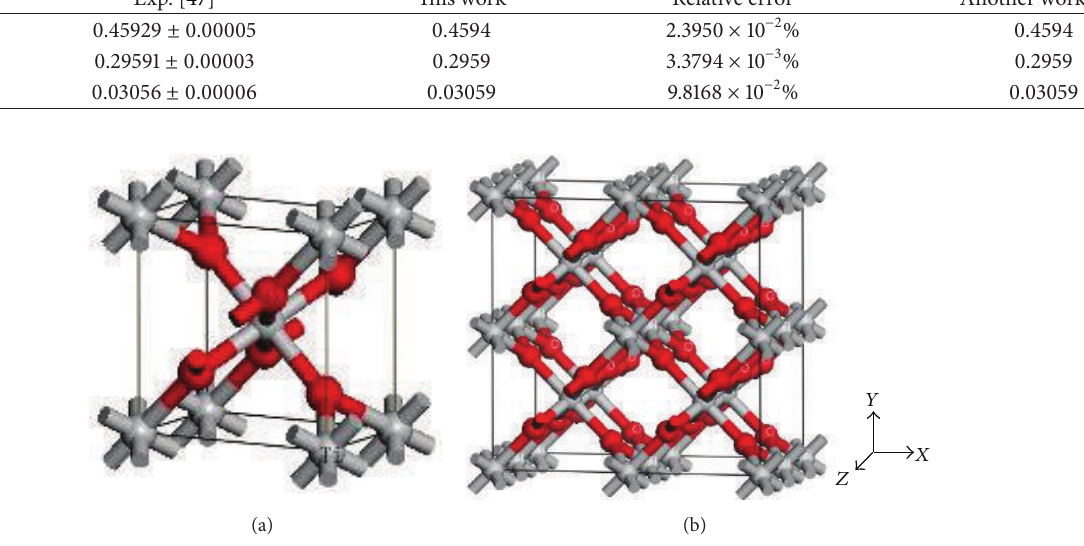
Figure 1: (a) The structure of rutile TiO 2 primitive cell. (b) The super cell structure of rutile TiO 2 (2 × 2 × 2)